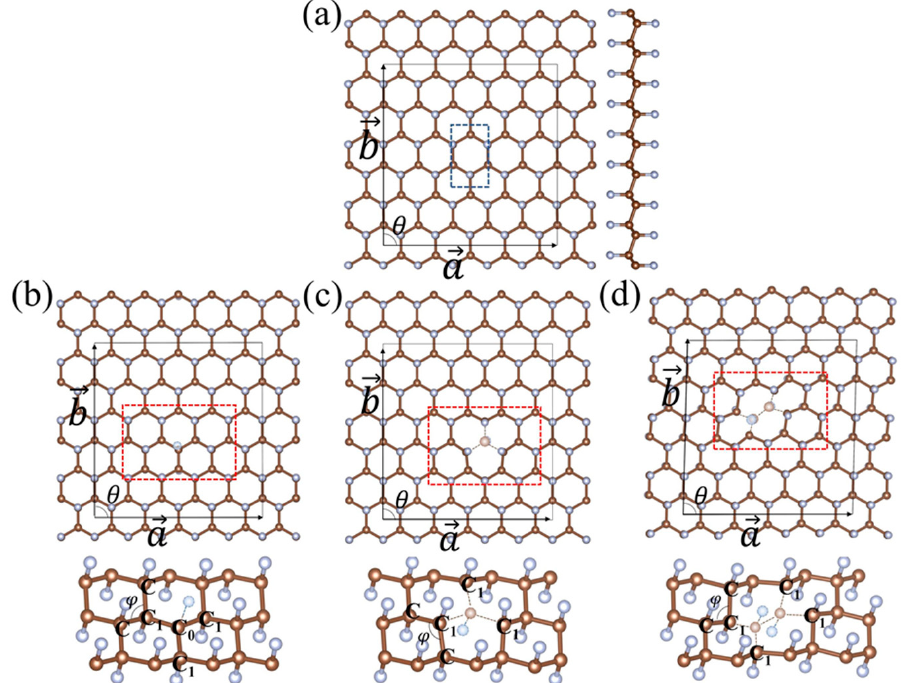
Figure 1. The 5 × 3 supercell of ( a ) fluorographene, and three types of vacancy defects: ( b ) fluorographene with F vacancy (V F -fluorographene), ( c ) fluorographene with single C–F vacancy (V sCF -fluorographene), and ( d ) fluorographene with double C–F vacancy (V dCF -fluorographene). The brown and light-grey spheres represent C and F atoms, respectively. The blue rectangular in ( a ) is the unit cell of fluorographene, while the red rectangular in ( b – d ) represent the areas greatly impacted by vacancy defects.